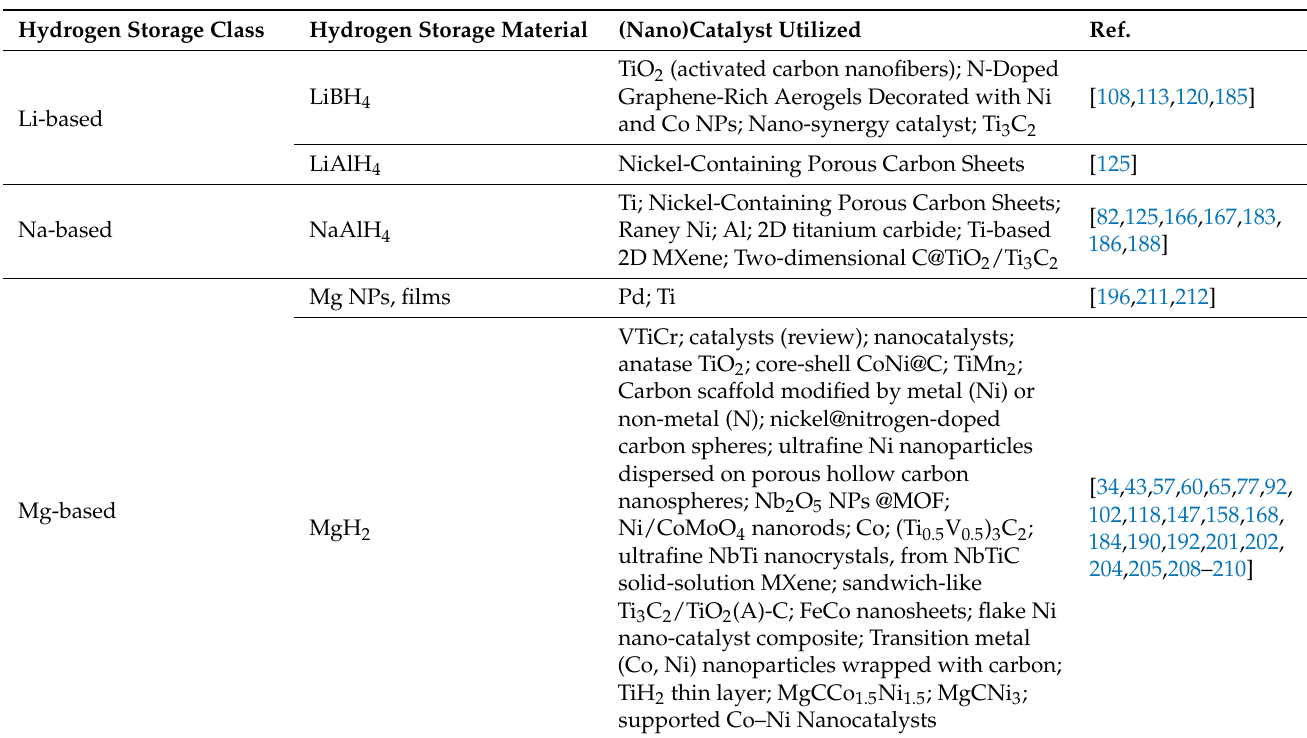
Table 9. Examples of recent advances using nanocatalysts to improve kinetic and thermodynamic properties of hydride-based systems in hydrogenation